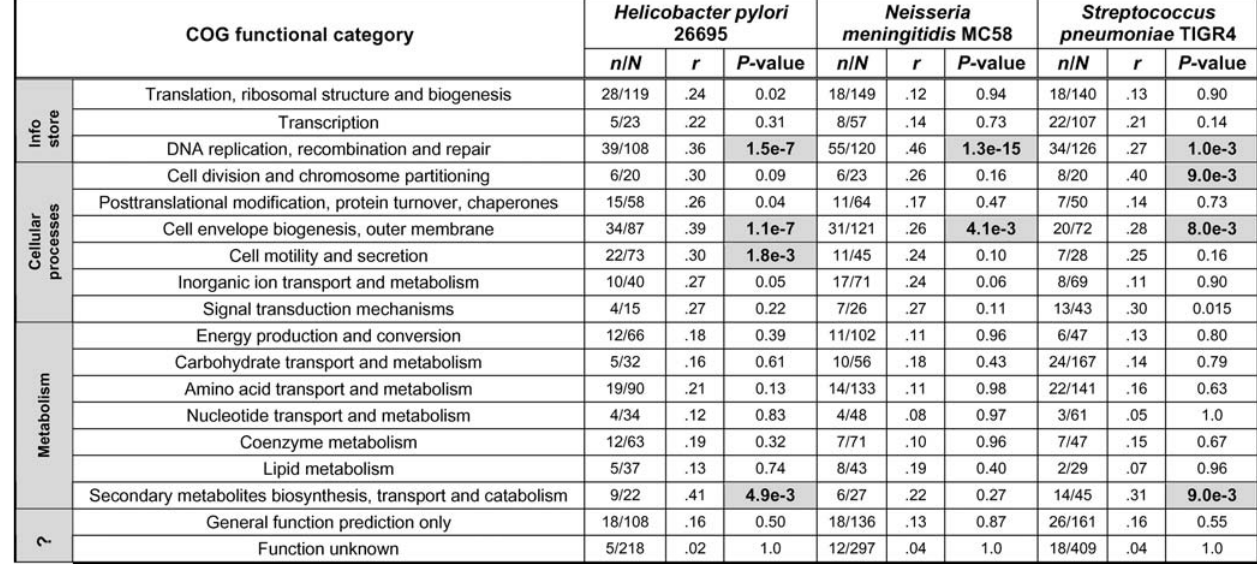
Figure 5. Functional Classification of SVGs in Three Microorganisms M is the total number of genes in a COG broad functional category, and m is the number of SVGs within that category. r ( = m/M ) is the proportion of SVGs in that category. The p -value is calculated using a hypergeometric distribution: let N = number of genes in the genome; n = number of SVGs identified; M = number of genes belonging to a particular category; m = number of SVGs belonging to a particular category: